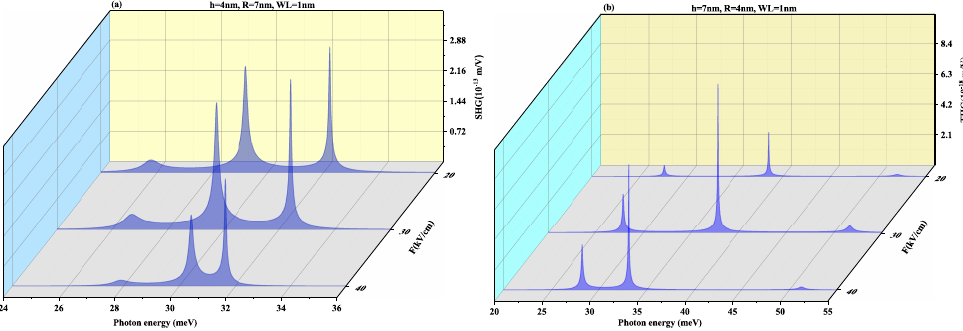
Figure 11. Third harmonic generation as a function of the photon energy for ( a ) oblate height R = 4 nm with radius R = 7 nm at WL thickness 1 nm ( b ) prolate QD with R = 4 nm, h = 7 nm with WL thickness = 1 nm for different values of lateral electric field F = 20,30 and 40